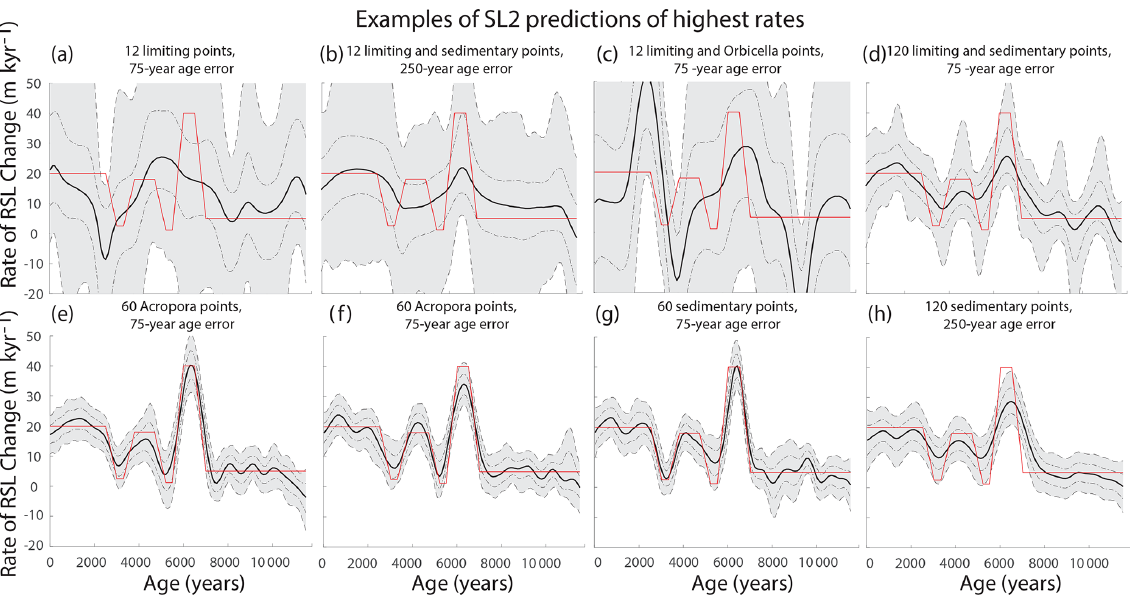
Figure 12. Eight examples of sensitivity tests showing various precision and error in rates for sea-level curve 2 (SL2). The red line in each plot shows the true rate, and the black and gray plots show the median and the 67% and 95% credible intervals (CIs), respectively. The quantity, precision, and age error of each dataset is labeled above the corresponding plot. Note that panels (e) and (f) have the same data characteristics, but the randomness (i.e., how the data are perturbed for the different seeds) produces different model